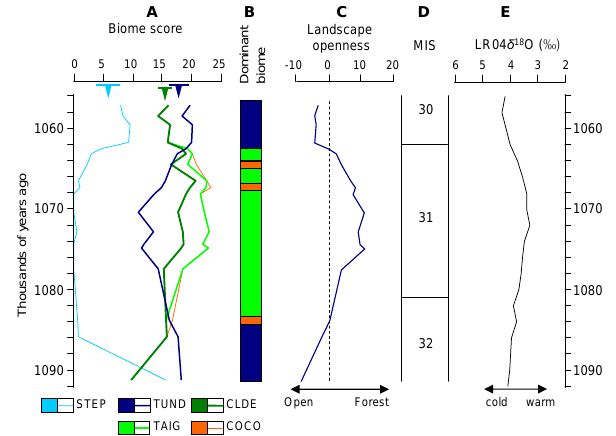
Fig. 6. Summary of paleoenvironmental trends between ∼ 1092 and ∼ 1057ka ago showing the (A) time series of individual biomes (tri- angles indicate the modern mean score of each respective biome; horizontal bars indicate the 95% uncertainty ranges); (B) dominant biomes; (C) characteristic of landscape openness calculated as the difference between the maximum score of forest biomes (MSFB) and the maximum score of open biomes (MSOB) at each level; and (D) marine isotope stage (MIS) boundaries and (E) stack of 57 globally distributed benthic δ 18 O records (after Lisiecki and Raymo, 2005). Biome names are abbreviated as follows: STEP – Fig. 6 cold steppe, TUND – tundra, CLDE – cold deciduous forest, TAIG – taiga, and COCO – cool conifer forest. Note that TAIG and COCO biomes are not present in the modern regional vegetation, and there- fore their score is identical to CLDE in the modern spectra (see Prentice et al., 1996, and Sect. 2.3 for